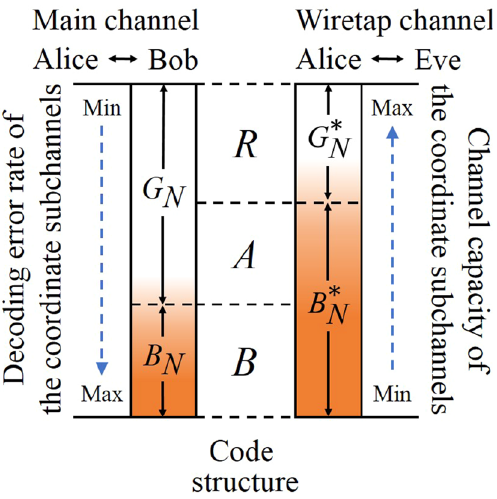
Figure 3. Code construction. The two columns which are colored by gradient represent the coordinate subchannels of the main channel and the wiretap channel. The deeper the color is, the worse the channel quality is.